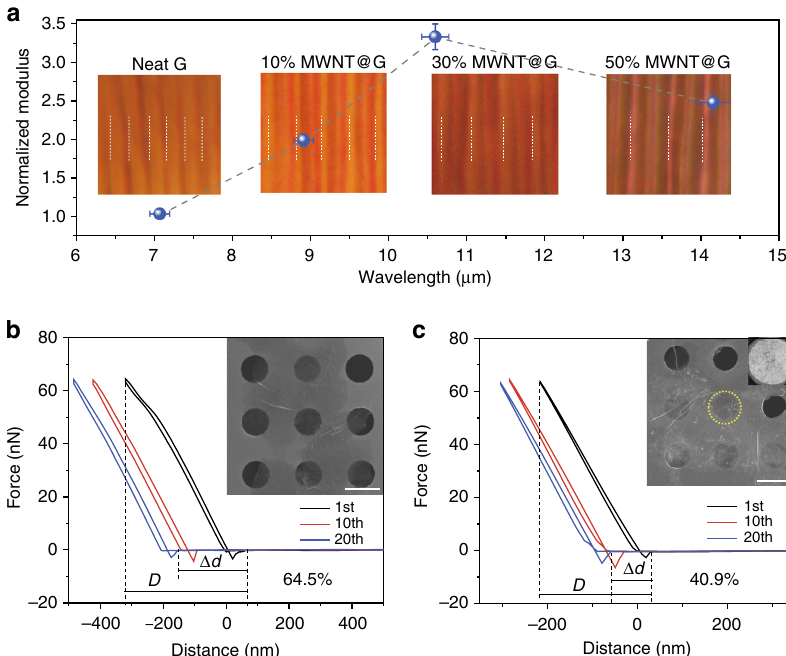
Fig. 6 The enhancement effects of synergistic graphene and MWNTs. a Normalized modulus of graphene laminates with increasing MWNTs doses. Error bars represent the s.d. of wavelengths of different graphene laminates and corresponding normalized moduli for at least fi ve measurements. The insets correspond to the optical microscopy images of buckled wave-like wrinkles with increasing wavelength. b , c Force-displacement curves of pure graphene fl ake ( b ) and synergistic fl ake ( c ) during 20 cycles. The insets are SEM and TEM images of isolated fl akes of carbon aerogels on copper grids. Scale bars, 1 μ m ( b , c